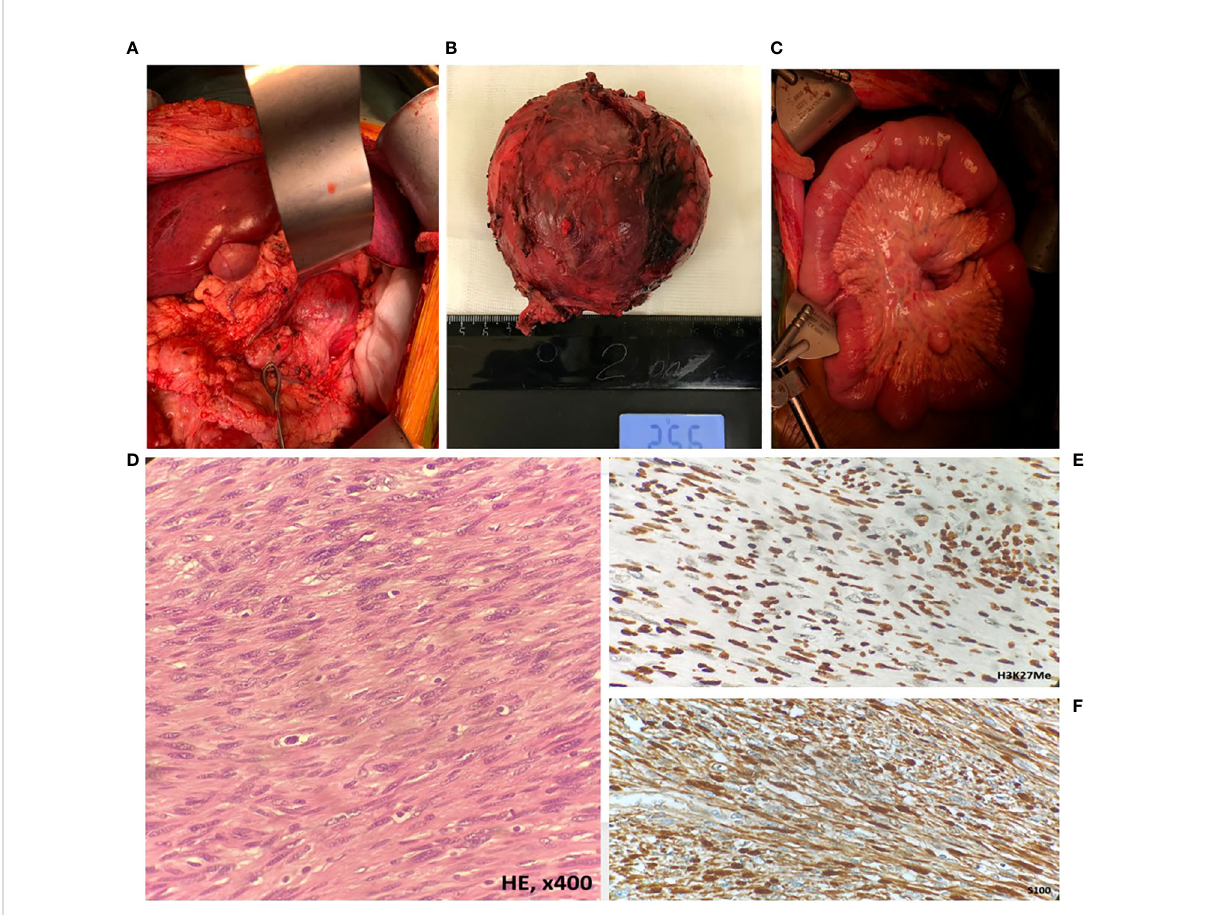
FIGURE 3 Intraoperative appearance and morphological assessment of the retroperitoneal tumor node and mesenteric tumor foci. (A, B) The solitary tumor node in the retroperitoneum (MPNST); (C) metastatic foci in the mesentery (MPNST); (D) MPNST spindle-shaped cells with scanty